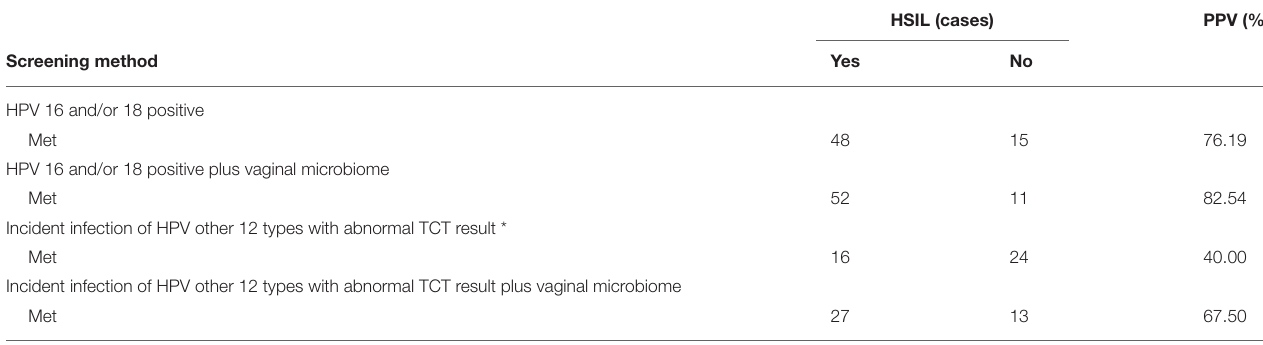
TABLE 4 | Accuracy of different strategy in screening patients with